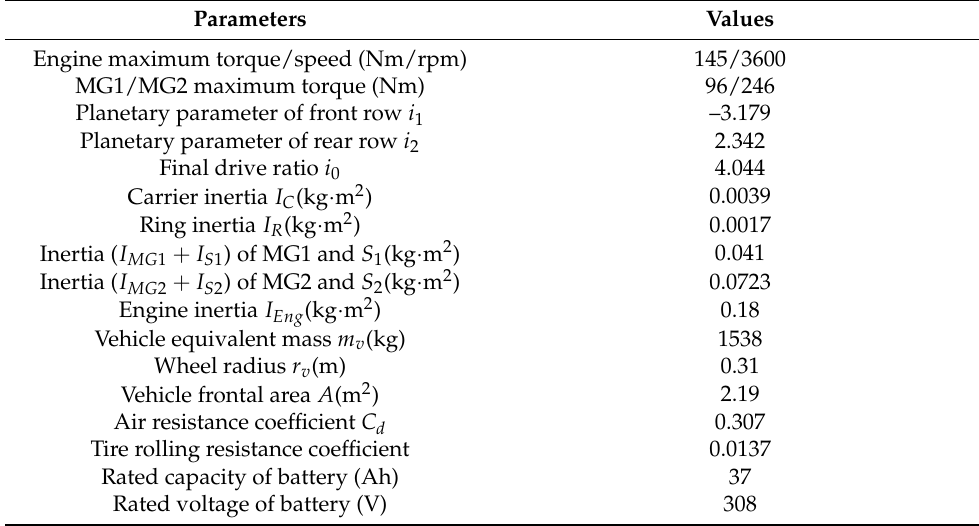
Figure 1. Structure diagram of powertrain system of a compound power-split hybrid electric vehicle. Table 1. Main structure parameters of hybrid powertrain system.